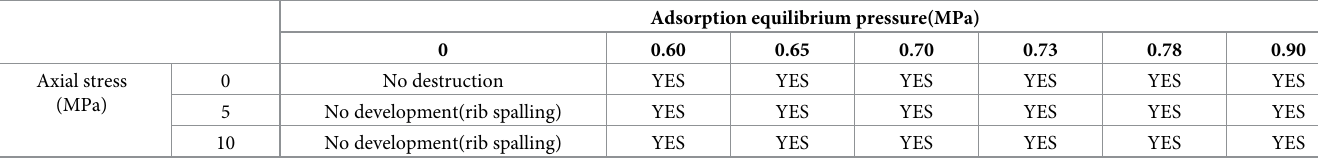
Table 2. Experimental results of the spallation.